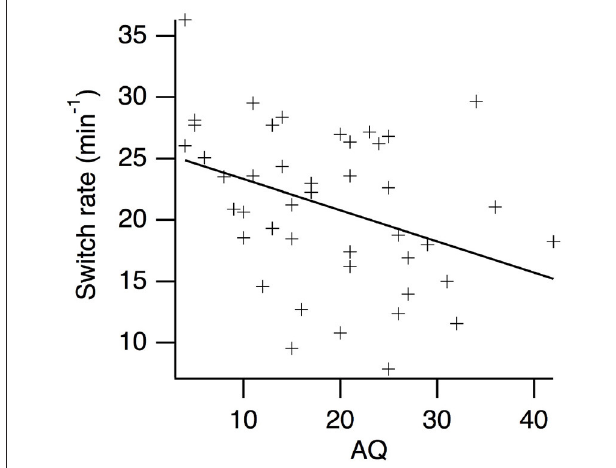
FIGURE 2 | Scatter plot of perceptual switching rates vs. AQ scores for the centrally presented, simple grating rival stimuli.